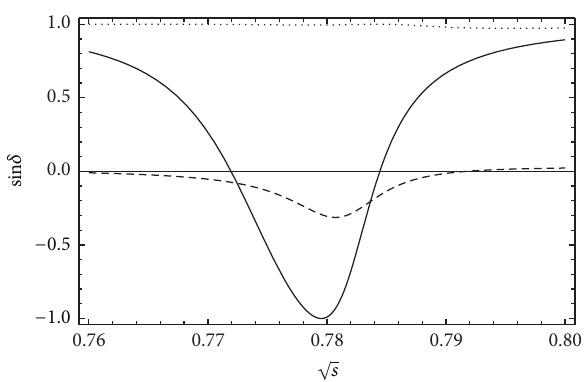
Figure 2: Plot of sin 𝛿 as a function of √𝑠 corresponding to central parametervaluesofCKMmatrixelementsfor 𝐵 𝜋 + 𝜋 − 𝜋 + 𝜋 − . The solid (dashed and dotted) line corresponds to sin 𝛿 (sin 𝛿 − and sin 𝛿 + ), respectively.